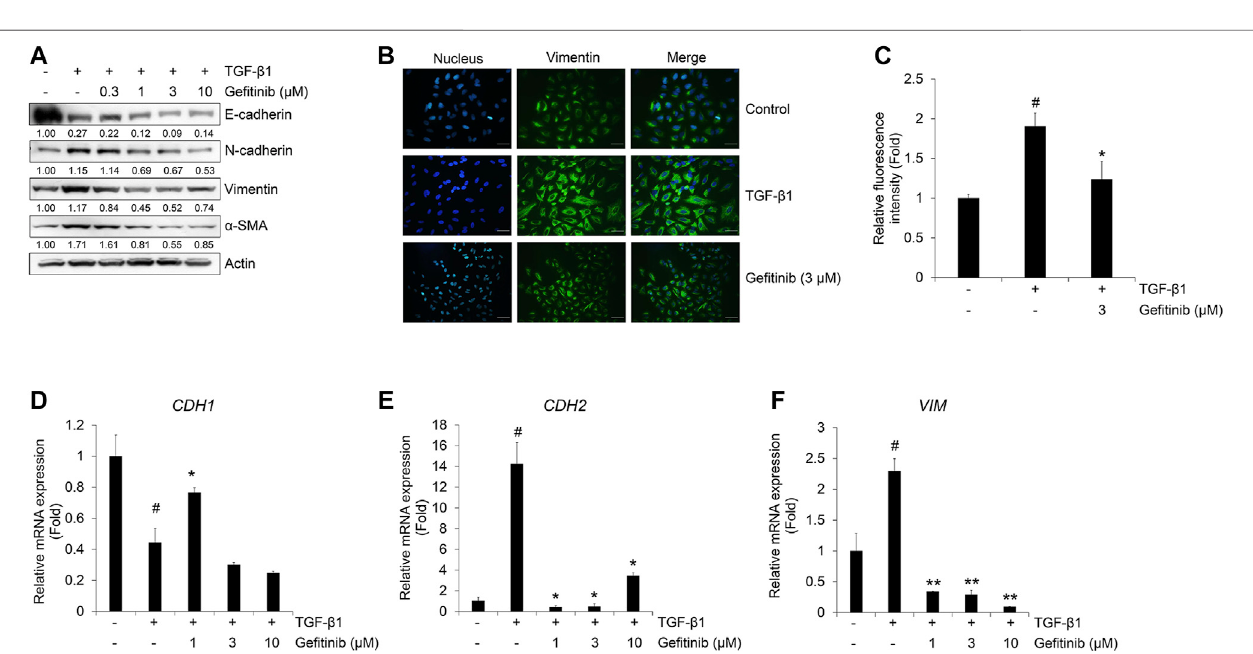
FIGURE 2 | Ge fi tinib inhibits TGF- β 1-induced expression of EMT markers. (A and B) Serum-deprived A549 cells were treated with TGF- β 1 (5 ng/mL) or in combinationwithge fi tinibfor72h. (A) Proteinexpressionofepithelialmarker(E-cadherin)andmesenchymalmarkers(N-cadherin,vimentin,and α -smoothmuscleactin) was determined by Western blot analysis. Actin was used as a loading control. (B and C) TGF- β 1-induced expression of vimentin was measured by immunocytochemistry. Nuclei were counterstained with DAPI. Scale bars (cid:2) 50 µm. (D – F) Serum-deprived A549 cells were incubated with TGF- β 1 (5 ng/mL) and ge fi tinib for 24 h. After RNA extraction and cDNA synthesis, we performed qRT-PCR to measure the expression of CDH1, CDH2 , and VIM mRNA using GAPDH as an internal control. # p < 0.01 vs. control; * p < 0.05, ** p < 0.01 versus the group treated with TGF- β 1 only.